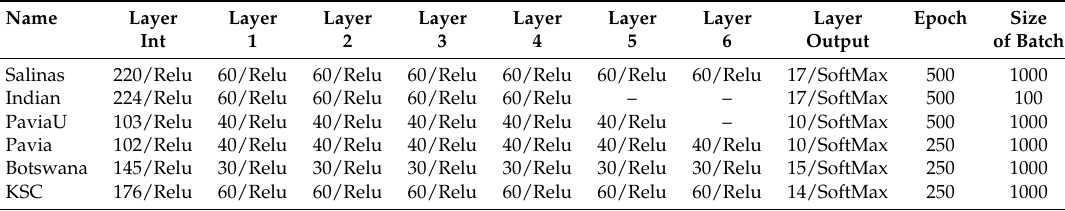
Table 2. Neural networks’ parameters and specification used in the experimentation stage. The first column shows the dataset name. In the following columns: the number of hidden layers and its parameter (number of hidden neurons and activation function used in the respective layer). Layer output indicates the number of output neurons and the activation function to these nodes. Epoch is the number of epochs employed in the training. Size of Batch is the portion of samples used for the deep neural networks in each